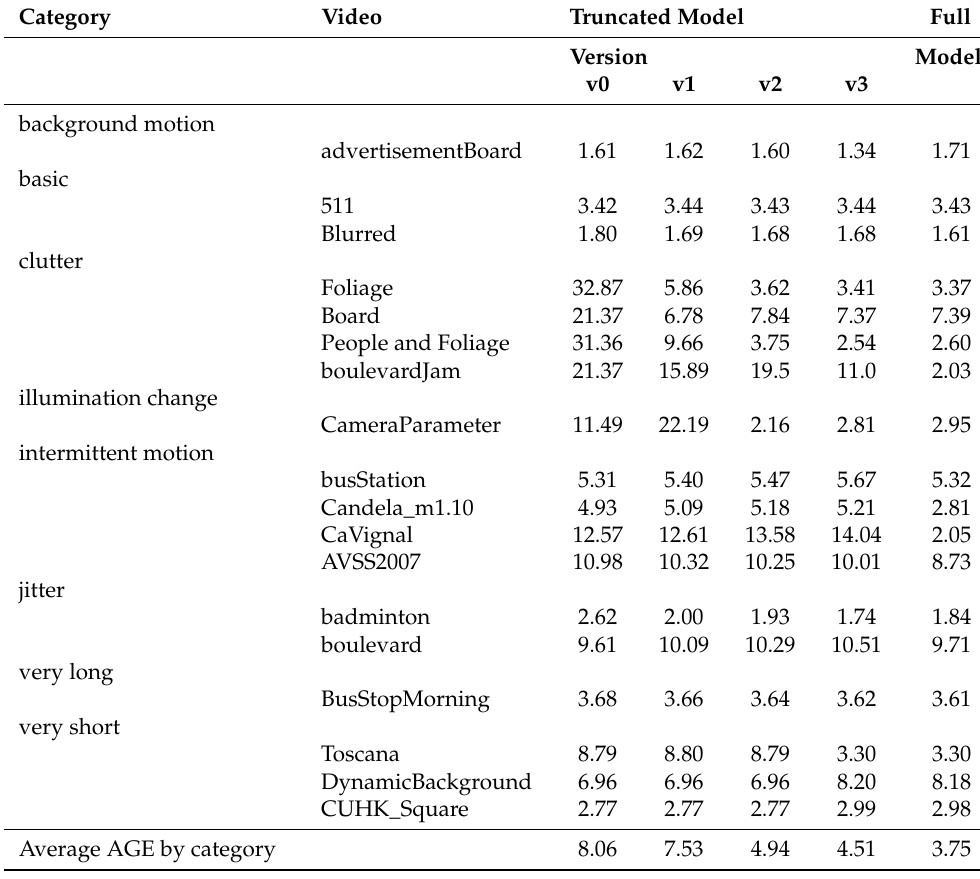
Table 4. AGE scores obtained using various truncated versions of the algorithm on 18 SBMnet sequences where a ground truth background is available.